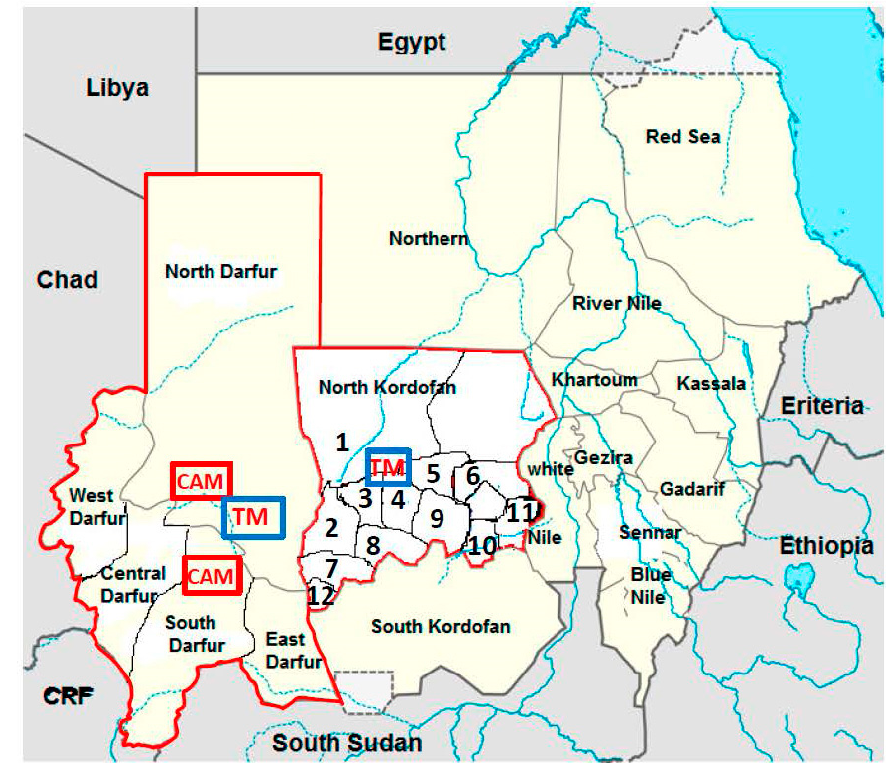
Figure 1. Map of Sudan and the region of North Kordofan and Darfur. The regions for gold mining are shown in squares labelled TM (traditional mining), and the location of the refugee camps in the Darfur regions are shown as squares labelled with CAM (refugee camps). The five regions with hepatitis outbreaks in Darfur are shown in the map as well as the 12 regions of North Kordofan, from where patients with sporadic hepatitis originated. These regions are labelled with the following